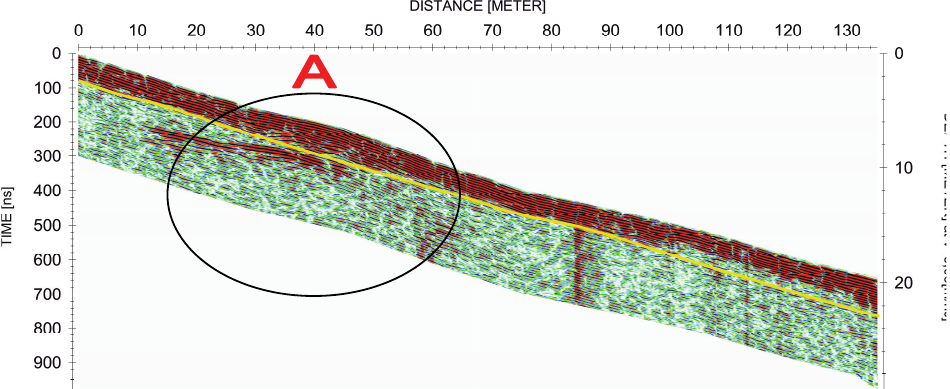
Fig. 4. Echogram P2 before introducing the procedure of gain function (1,728/0,0024/23), running average and topographical correction, with the hyperboles of reflections from elements lying on the ground surface and the distance of these elements from the profile line marked